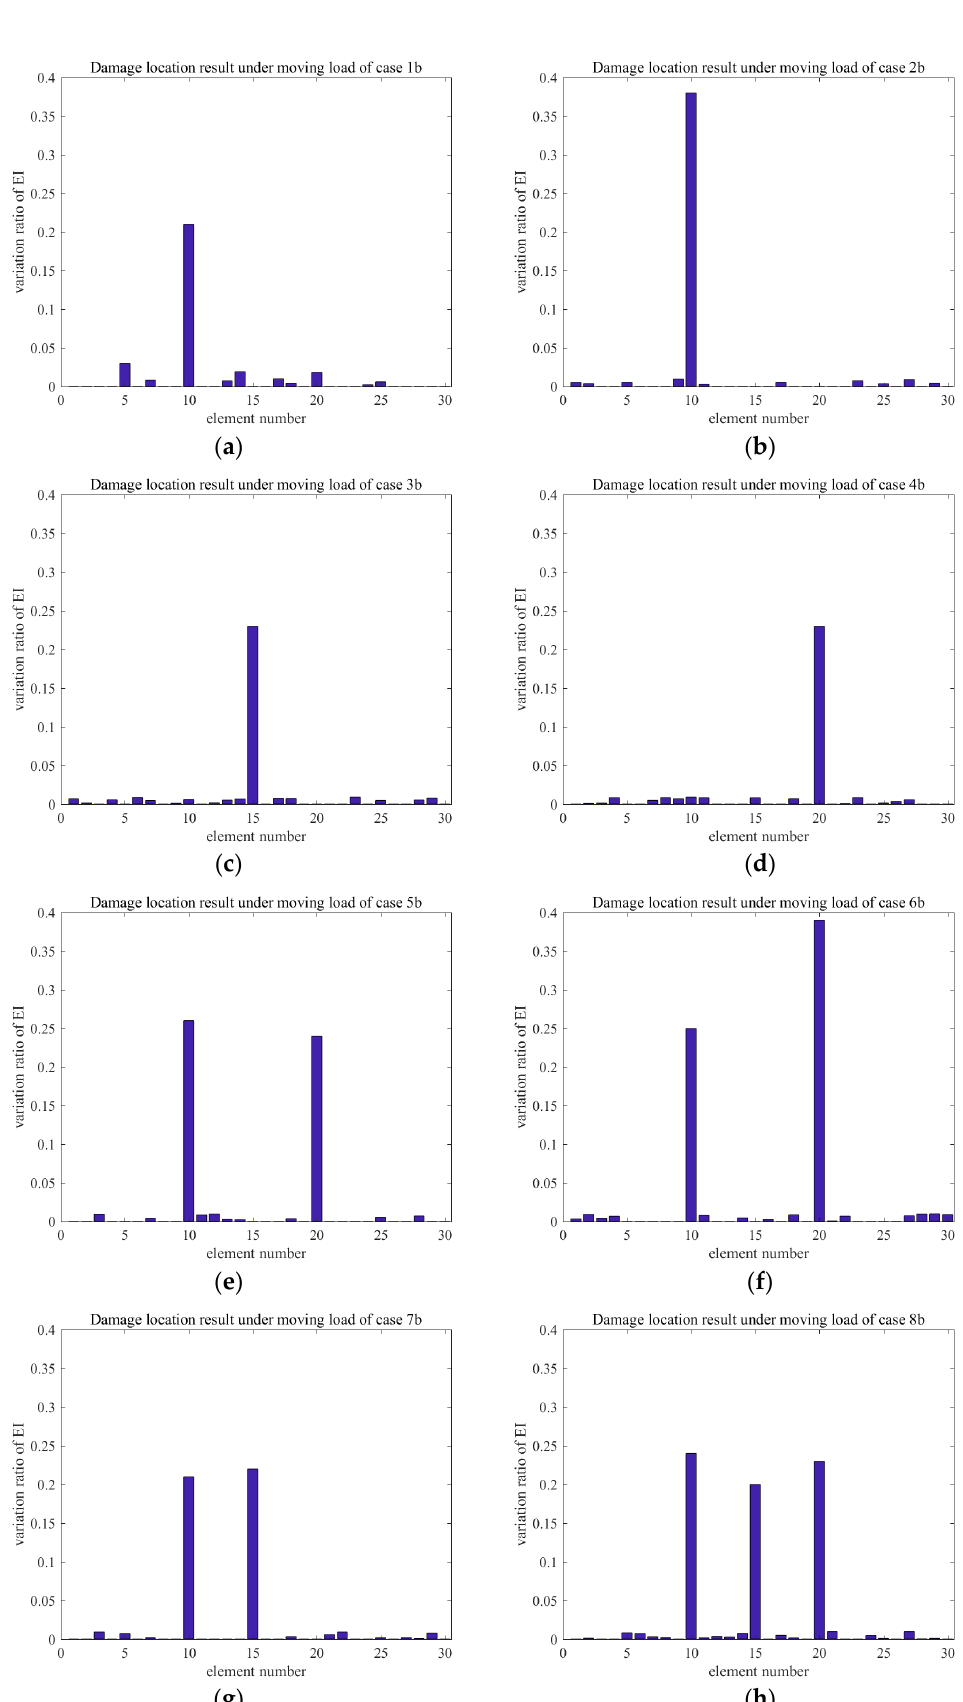
Figure 16. Damage location results under moving load of Group B: ( a ) DMG1b; ( b ) DMG2b; ( c )